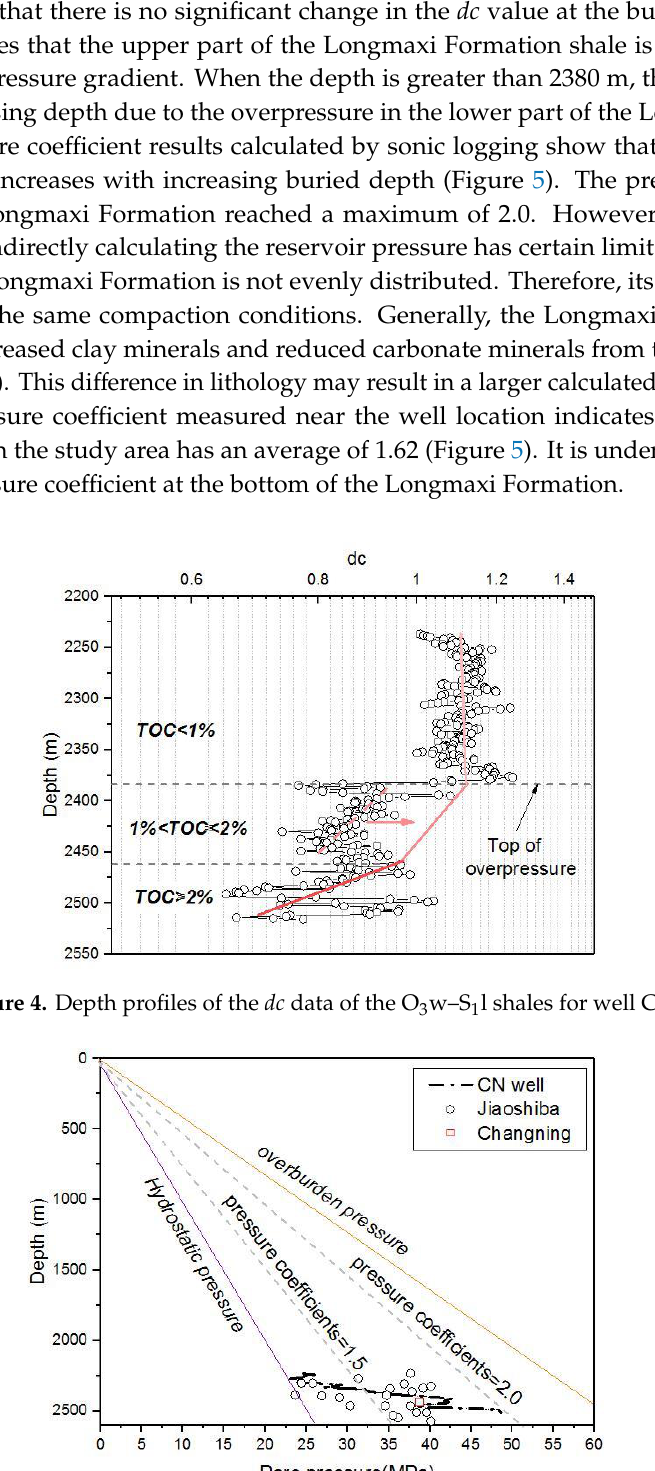
Figure 5. Depth profiles of the reservoir pressure coefficient results calculated by sonic logging of